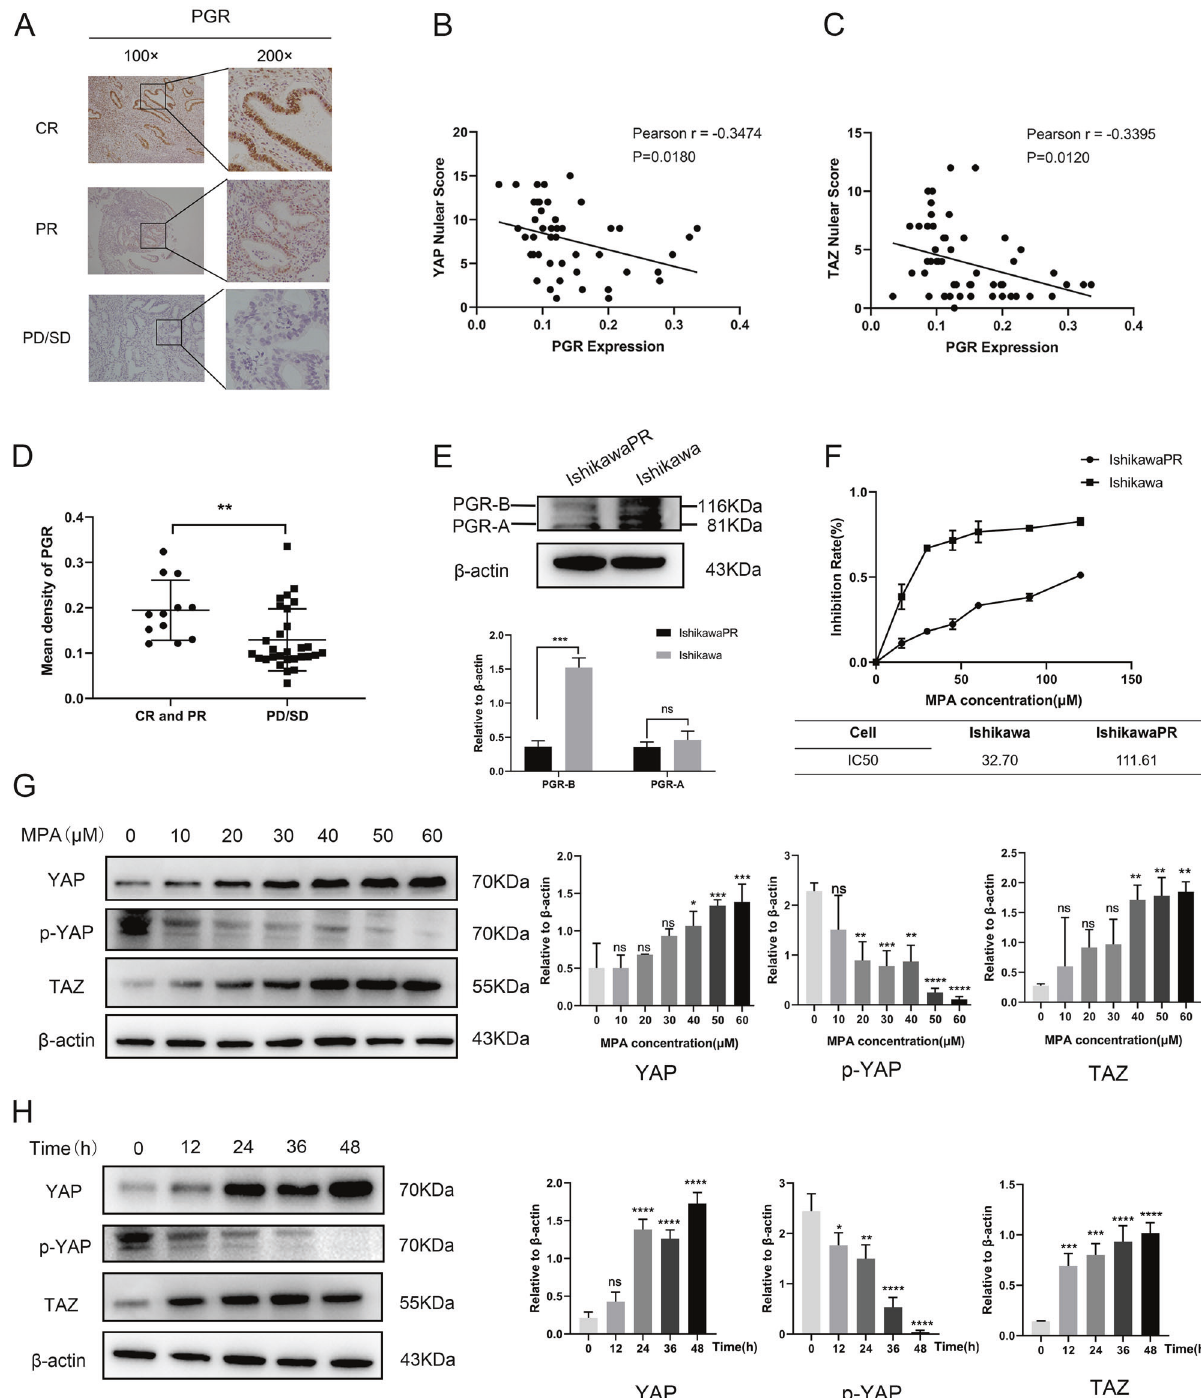
Fig. 2 Negative correlations between YAP/TAZ and PGR and the in fl uence of MPA on YAP/TAZ in progestin resistant cells. A Representative images of IHC staining of PGR in endometrial tissues after progestin treatment in CR, PR, PD/SD groups. B The correlation between the expression of nuclear YAP and the expression of PGR in patient tissues that received progestin treatment. C The correlation between the expression of nuclear TAZ and the expression of PGR in patient tissues that received progestin treatment. D Mean density of PGR in endometrium after progestin treatment in CR and PR, PD/SD groups analyzed by Image-Pro Plus 6.0. E The expression of PGR-A and PGR-B in Ishikawa cell and IshikawaPR cell con fi rmed by western blotting. F The growth curves and IC50 of Ishikawa cell and IshikawaPR cell with different concentrations of MPA. G The expression of YAP, p-YAP, and TAZ in IshikawaPR cell with different concentrations of MPA by western blotting. H The expression of YAP, p-YAP, and TAZ in IshikawaPR cell at different time points with fi xed concentration of MPA by western blotting. * P < 0.05, ** P < 0.01, *** P < 0.001, and **** P < 0.0001.